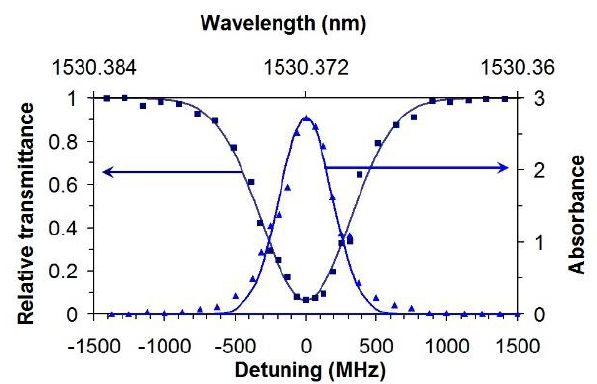
Figure 2. Transmittance/absorbance profiles of the utilized acetylene cell at the P9 spectral line, centered at 1530.372 nm. Solid lines present theoretical fittings with the Gaussian profile of the absorption of 500 MHz FWHM spectral width.